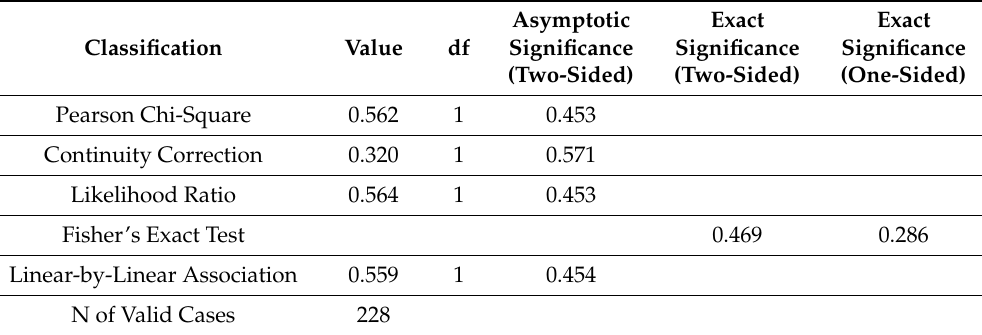
Table 8. Chi-square test for survival rate.